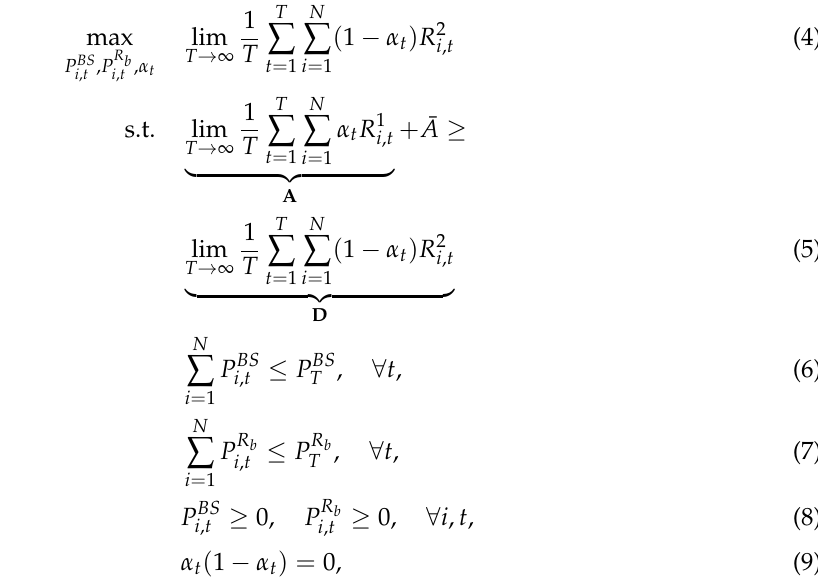
powers at source and relay nodes for the corresponding maximum rates R 1 ∗